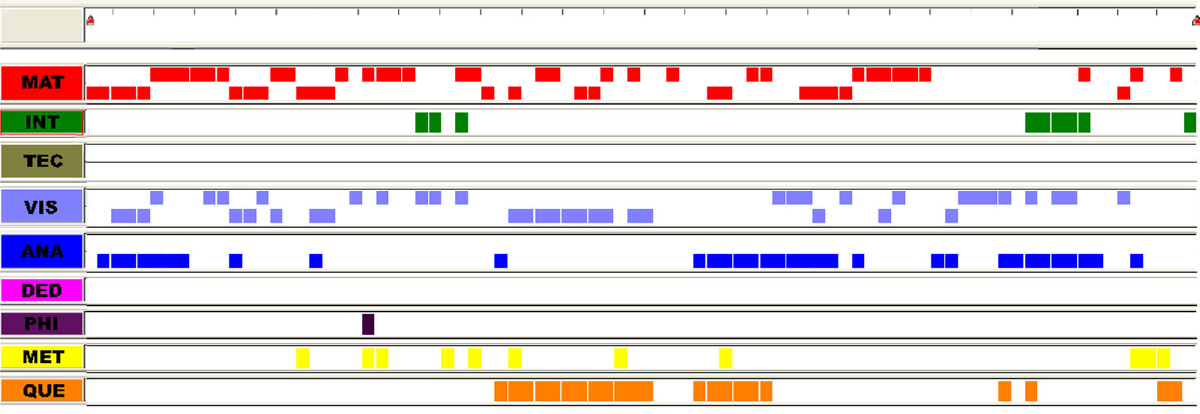
episode.FIG. 4. Timeline of the charge density